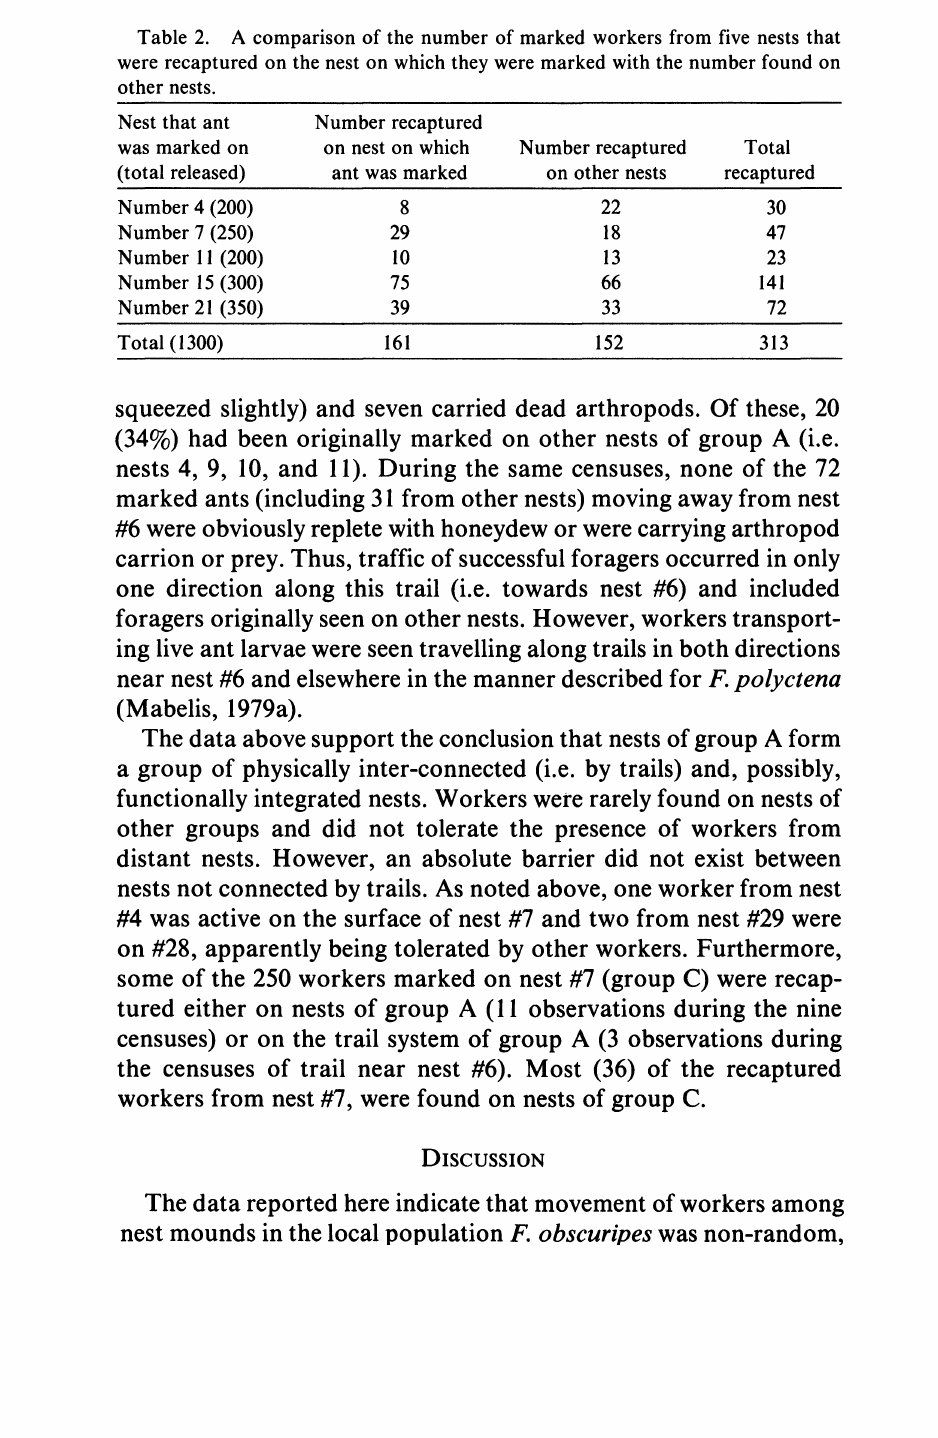
Table 2. A comparison of the number of marked workers from five nests that were recaptured on the nest on which they were marked with the number found on other nests. Nest that